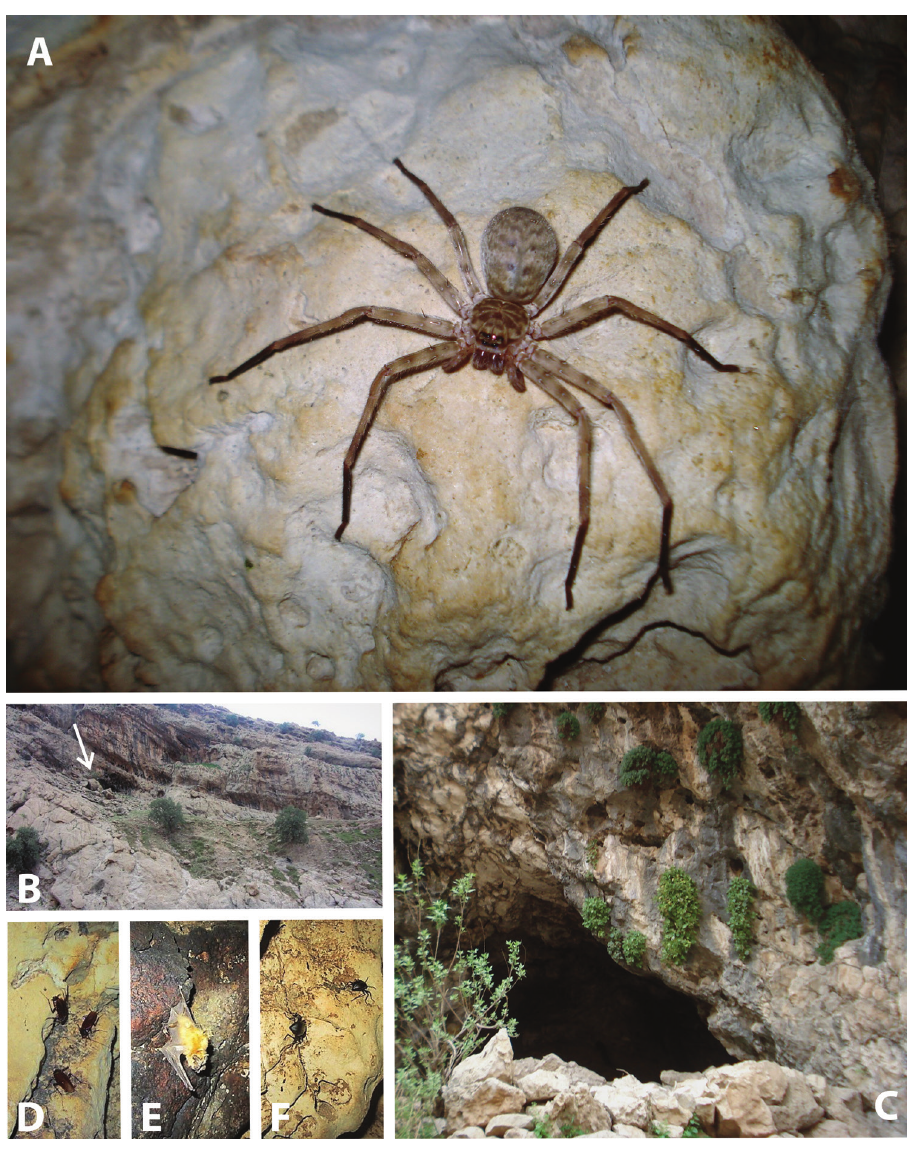
Figure 3. A Habitus of Spariolenus fathpouri sp. n., paratype female, alive in the type locality B Pebdeh Cave, Iran, the type locality, entrance (arrow) C ditto, Pebdeh Cave D Blattidae E dead Bat suffered from fire F Coleopteran